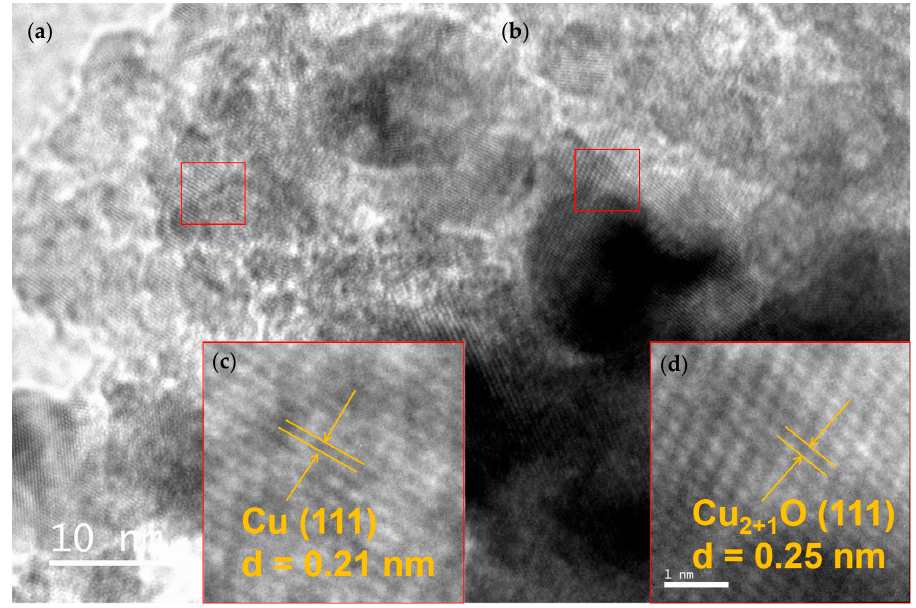
Figure 3. TEM image of ( a ) Ti 3 C 2 T x , ( b – d ) Cu/Ti 3 C 2 T x .